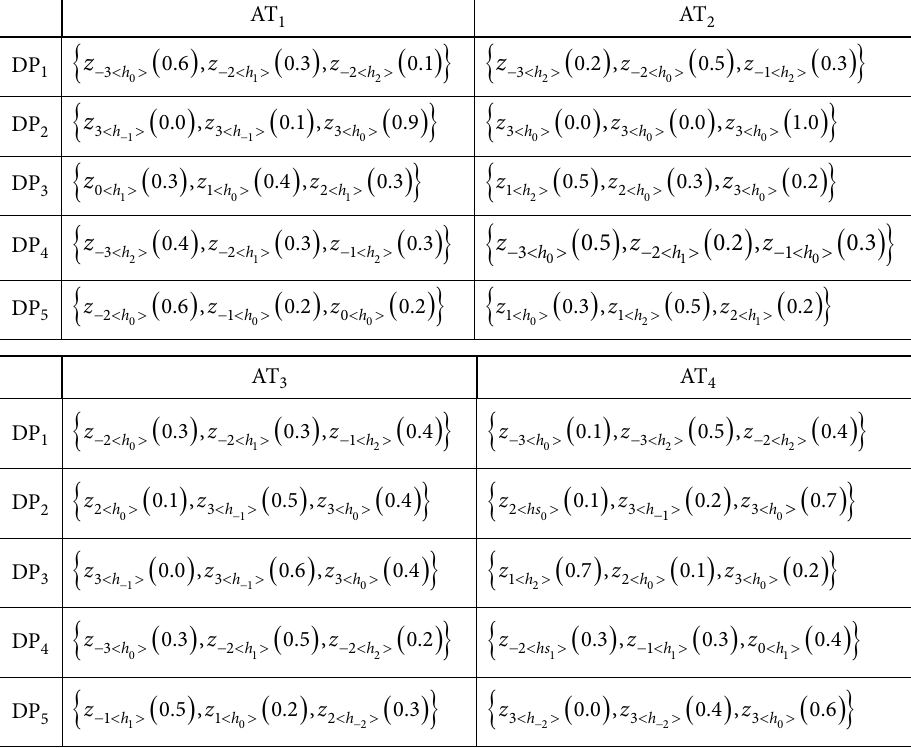
Table 4. The normalized PDHLTSs evaluation of each alternative is provided by e 1 AT 1 AT 2 DP